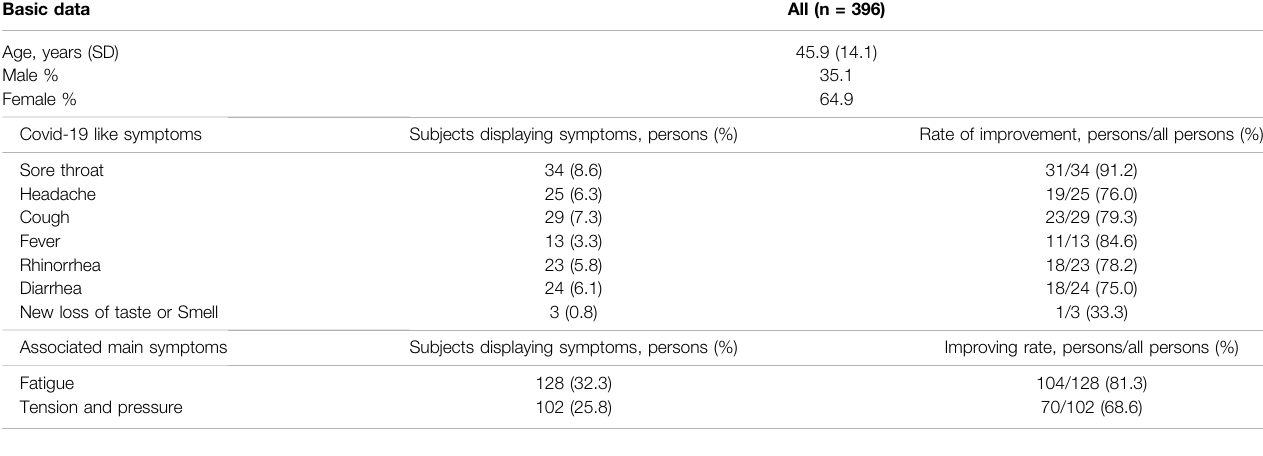
TABLE 1 | Demographic and clinical characteristics of the subjects with Covid-19 like symptoms. Basic data